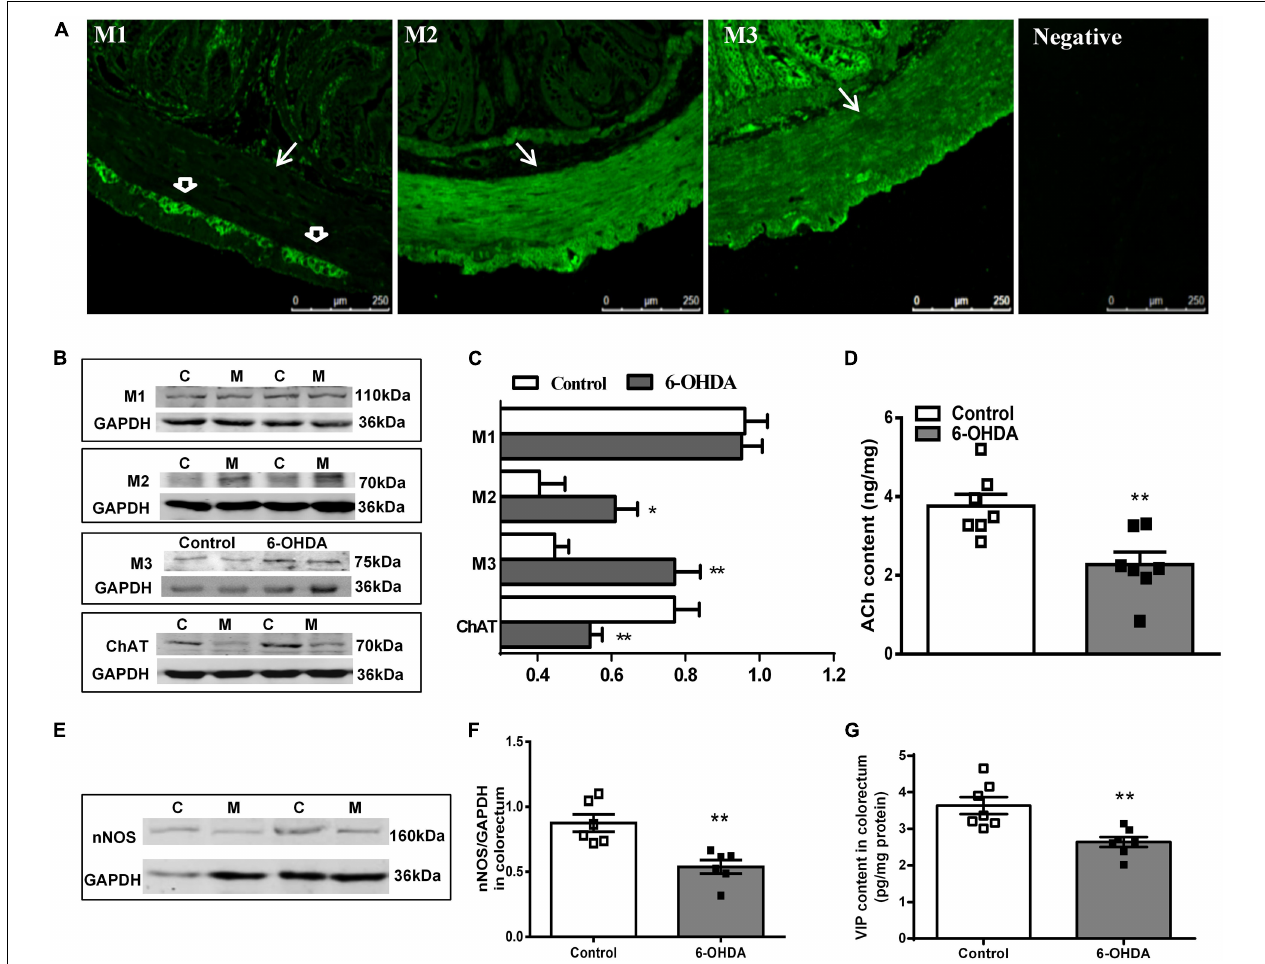
FIGURE 4 | (A) Distribution of M 1 R, M 2 R, M 3 R in the colorectum of control rat. The arrow indicates the muscular layer; the open arrowhead indicates the myenteric plexus. Negative control without the primary antibodies. (B,C) Representative western blot and bar charts show levels of the M 1 R, M 2 R, M 3 R, and ChAT protein in the colorectum of control (C) and 6-OHDA rats (M) ( n = 7). Glyceraldehyde-3-phosphate dehydrogenase (GAPDH) was used as an internal control. (D) ACh content in the colorectal muscularis externa ( n = 7). (E,F) Representative western blot and histogram show levels of the nNOS protein in the colorectum ( n = 6). (G) VIP contents in the distal colonic and colorectal muscularis externa ( n = 7). * P < 0.05, ** P <